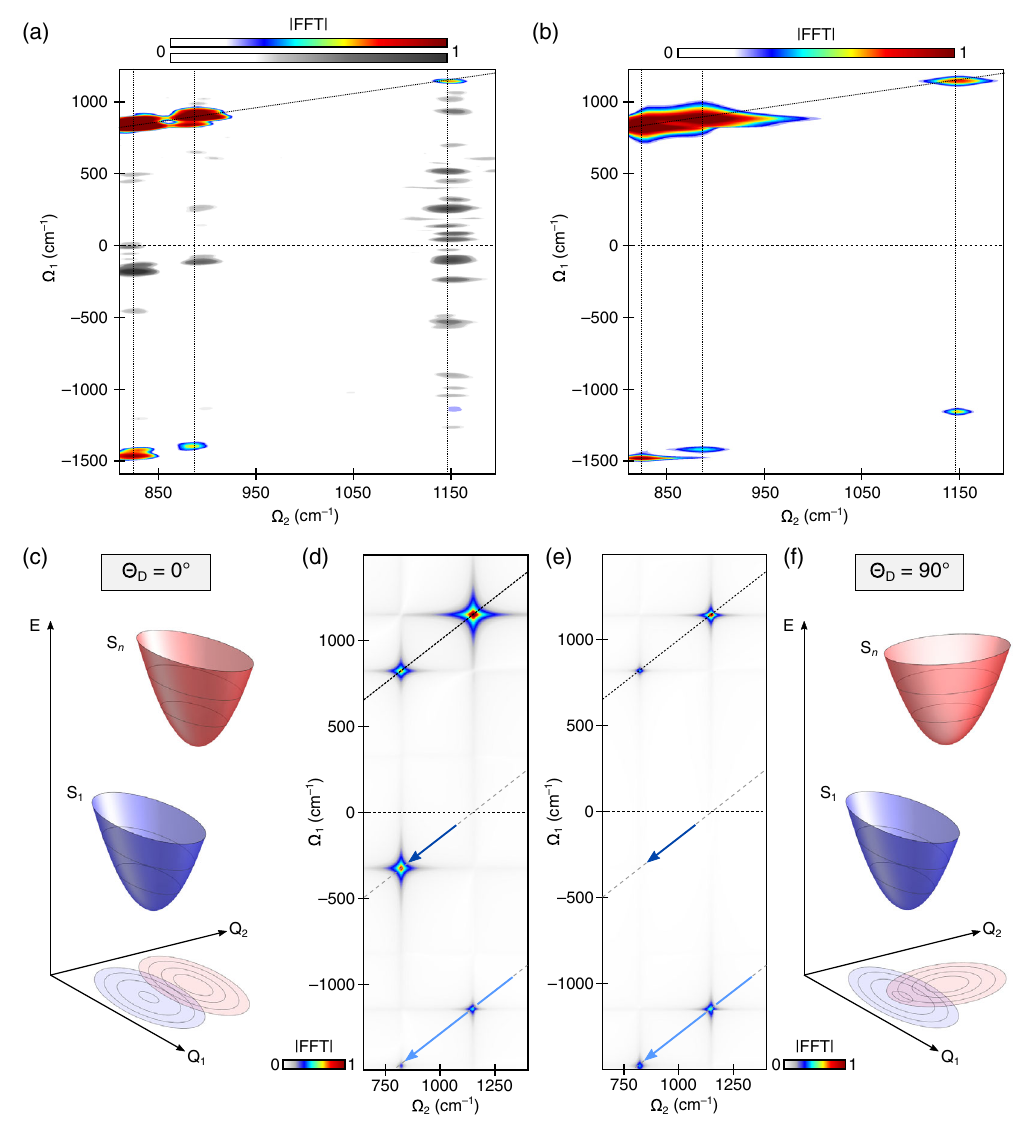
FIG. 5. Effect of mode mixing in 2D-ISRS for a harmonic model. The experimental spectra of GFP (a) are compared with the fit (b) obtained by considering the modes at 80, 822, 888, and 1147 cm − 1 , which are those relevant for the off-diagonal peaks at Ω ¼ Ω − 2294 cm − 1 . These features, not captured by the LDHO model, are explained by a Duschinsky rotation of Θ ¼ 90 ° between 1 2 D the 1147- and 80 -cm − 1 modes, and they are highlighted by the rainbow color bar in the experimental map. The gray scale has been used for the peaks not relevant for these processes and already assigned by the LDHO model. In the bottom panels, the effect of the Duschinsky rotation is dissected by considering the minimal scenario of a single mode ( 1147 cm − 1 ), coupled to a nondisplaced low- ¼ 0 ° (a,b), the system is described by a linearly frequency mode ( 80 cm − 1 ) and detected on a “ spectator ” mode ( 822 cm − 1 ). For Θ D displaced harmonic model, and a displacement d 1147 2 ≠ 0 causes the combination bands involving this mode and its overtones. The blue and cyan arrows indicate the position of combination bands associated with 1147 cm − 1 and 2 × 1147 cm − 1 , respectively. (c,d) In the ¼ 90 ° between the projections of S presence of a Duschinsky rotation Θ 1 and S n along the normal coordinates of the 1147- and D 80 -cm − 1 modes, the combination band associated with the fundamental of the 1147 cm − 1 is along the 1147- and 80 -cm − 1 the excited states S 1 and S n modes leads to a suppression of the subdiagonal peak at the fundamental frequency Ω 1 ¼ Ω 2 − 1147 cm − 1 and enhances the intensity of the overtone couplings [Figs. 5(e) and 5(f)]. The suppression is maximized at [Figs. 5(c) and 5(d), blue and cyan arrows, respectively]. Θ ≠ 0 ° between projections of ¼ 90 ° for these values of the parameters and is above Conversely, a rotation of Θ D D